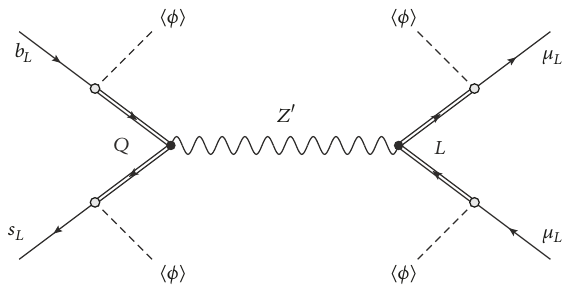
Figure 1: Generation of O 9 and O 10 in the model of [2]. The mixing between the SM fermions and the vector-like ones induces semi- Leptonic four-fermion interactions.